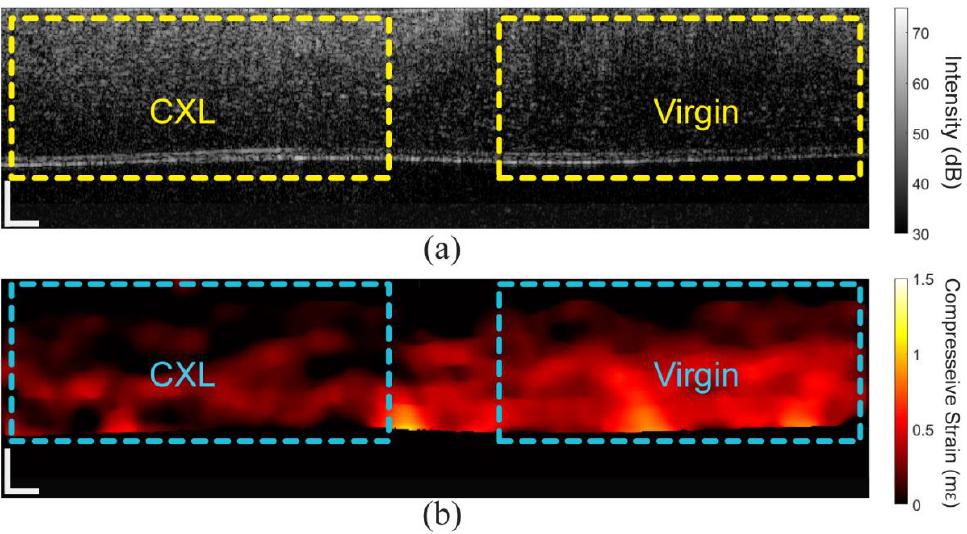
Figure 11. OCT and OCE images of the half-CXL in vivo rabbit cornea. ( a ) OCT image and ( b ) compressive strain map. The dashed boxes show the regions utilized for quantitative analyses. The scale bars are 100 μm.